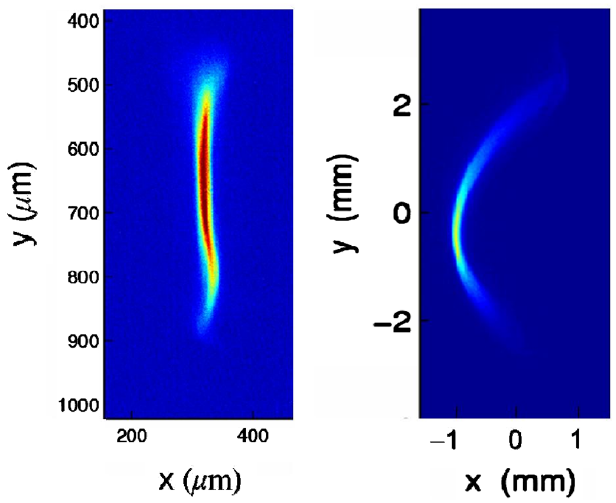
FIG. 29. (Color) Beam vertically streaked across OTR screen (left) and YAG screen (right) using rf deflector (bottom is bunch tail). At left, variations in horizontal position along the vertical coordinate (time) lead to an increased projected emittance above the slice. At right, a YAG screen after the 35-deg spectrometer bend at 135 MeV reveals a slice (intrinsic) energy spread of < 6 keV rms.